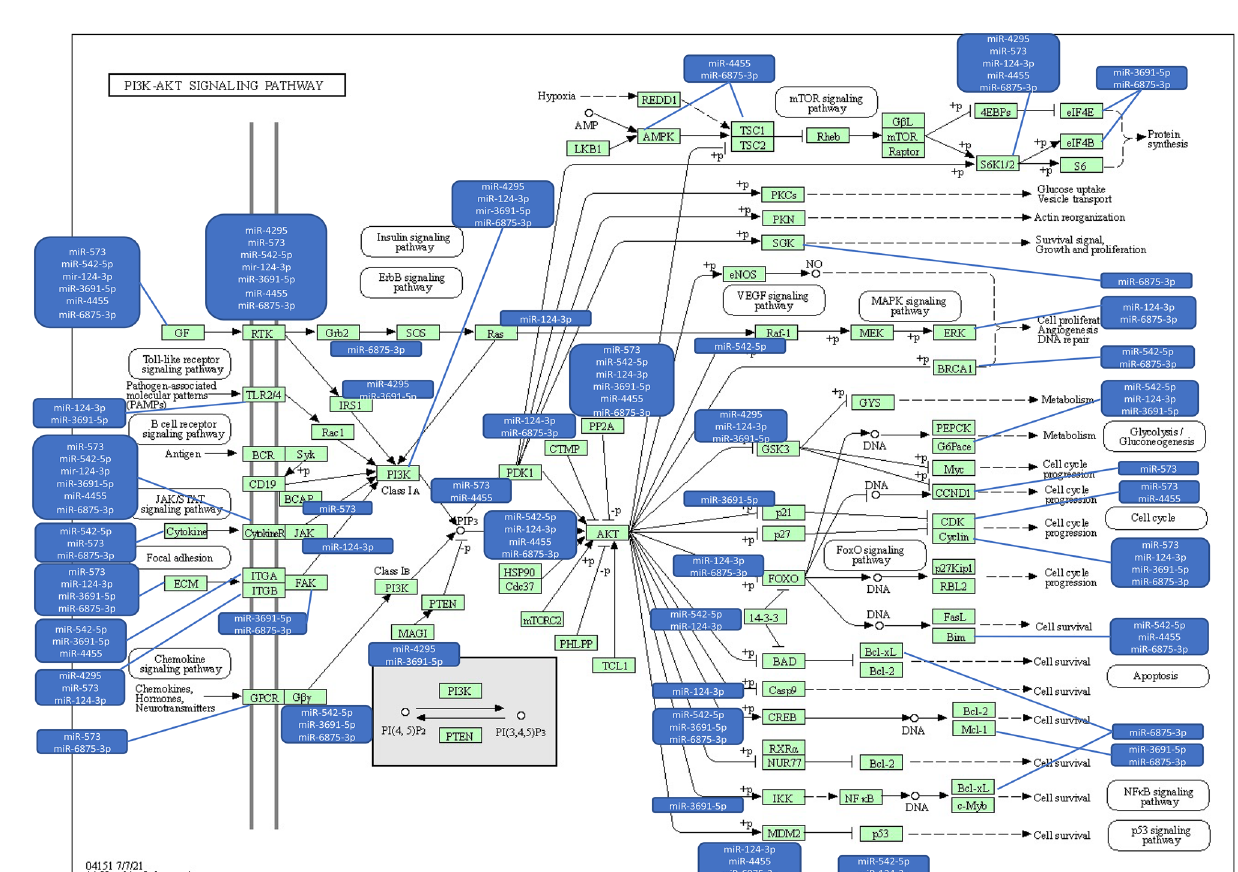
Figure 3. Network, pathways, and functions for the relevant miRNAs associated with PI3K/Akt, MAPK pathways (with the Copyright permission of KEGG https:// www. kegg. jp/ kegg/ kegg1. html with the reference number Ref: